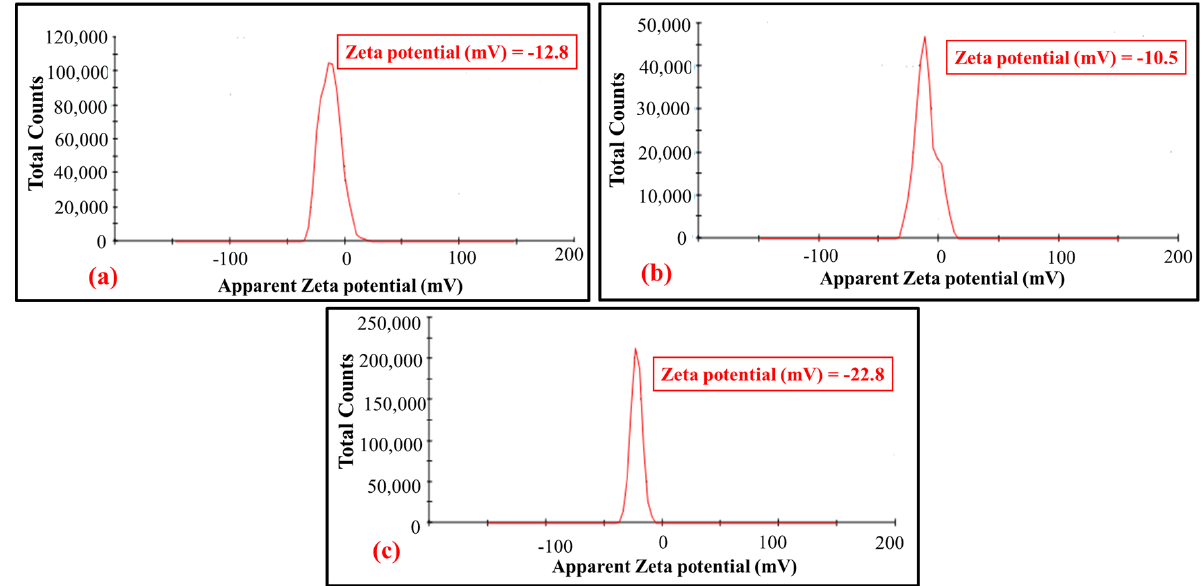
Figure 8. Zeta potential of the ( a ) as-fabricated nanocalcite @ PF, ( b ) acidic prewetted nanocalcite @ PF, ( c ) basic prewetted nanocalcite @ PF.